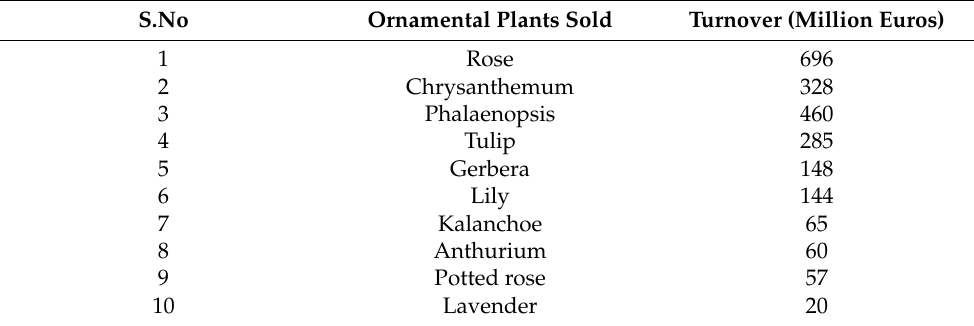
Table 1. Turnover of the top 10 ornamental plants in the Royal FloraHolland auction in 2019. S.No Ornamental Plants